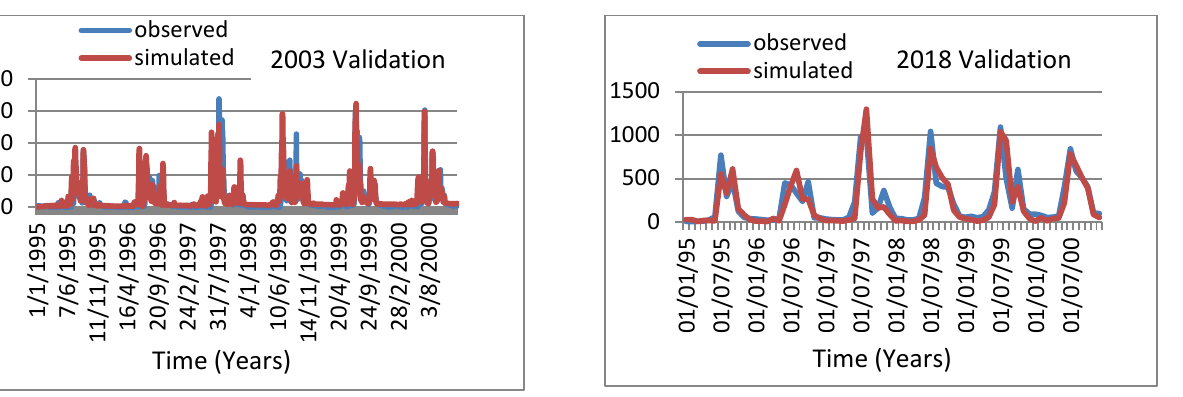
Figure 23 Line graph showing simulated and observed runoff vs time at monthly time step for the year 2018